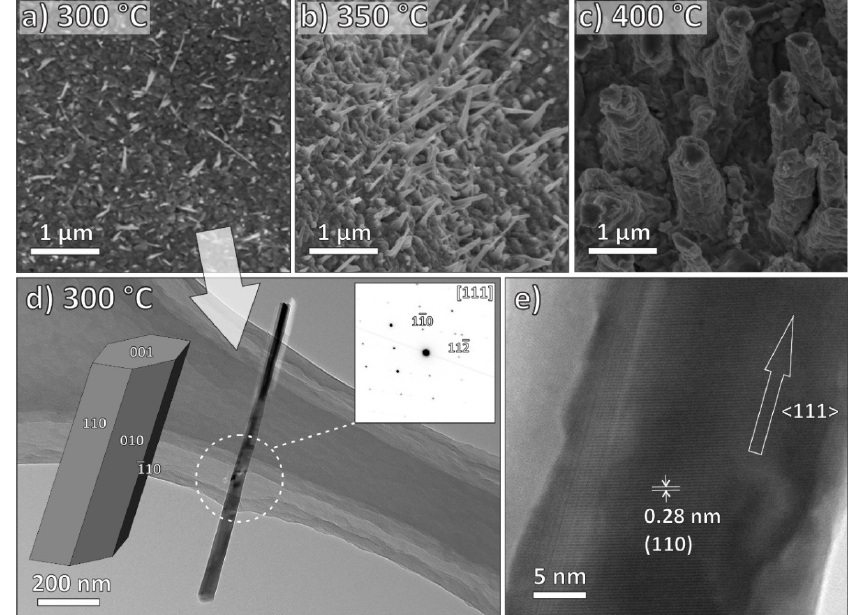
Figure 4. SEM images of copper oxide nanostructures synthesized at di ff erent growth temperatures: ( a ) 300 ◦ C, ( b ) 350 ◦ C, and ( c ) 400 ◦ C, respectively; time period of growth was 30 min. ( d ) Top-view TEM image of a single copper oxide nanostructure grown at a processing temperature of 300 ◦ C viewed along [111] zone axis (corresponding SAEDP in inset) and an NW model in the same orientation. ( e ) High-resolution TEM image of the copper oxide nanostructure with the marked interplanar spacing of 0.28 nm. From the SAEDP, we can obtain that the growth direction of the CuO NW is < 111 >